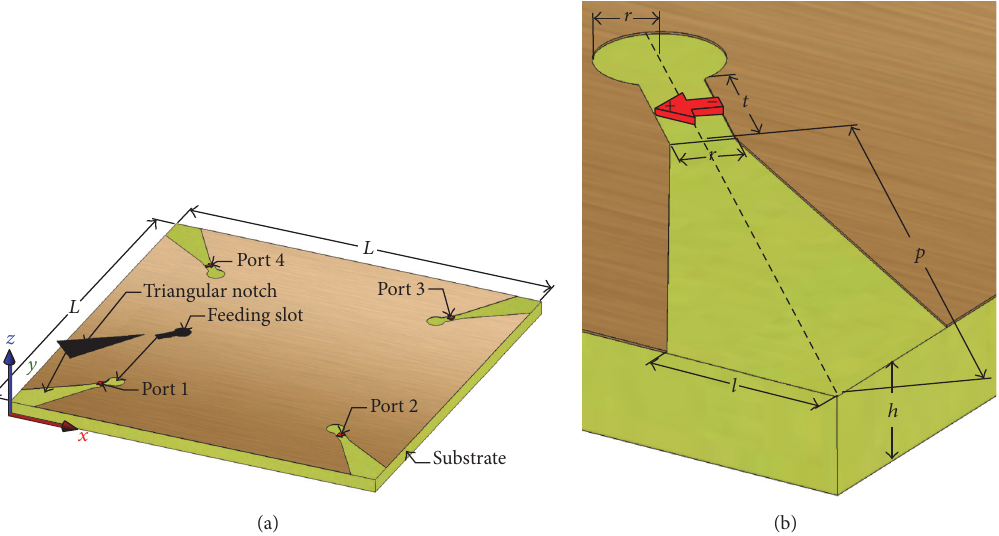
Figure 1: 3D geometry of the proposed notch antenna system: (a) overall view and (b) elaborate view of Notch